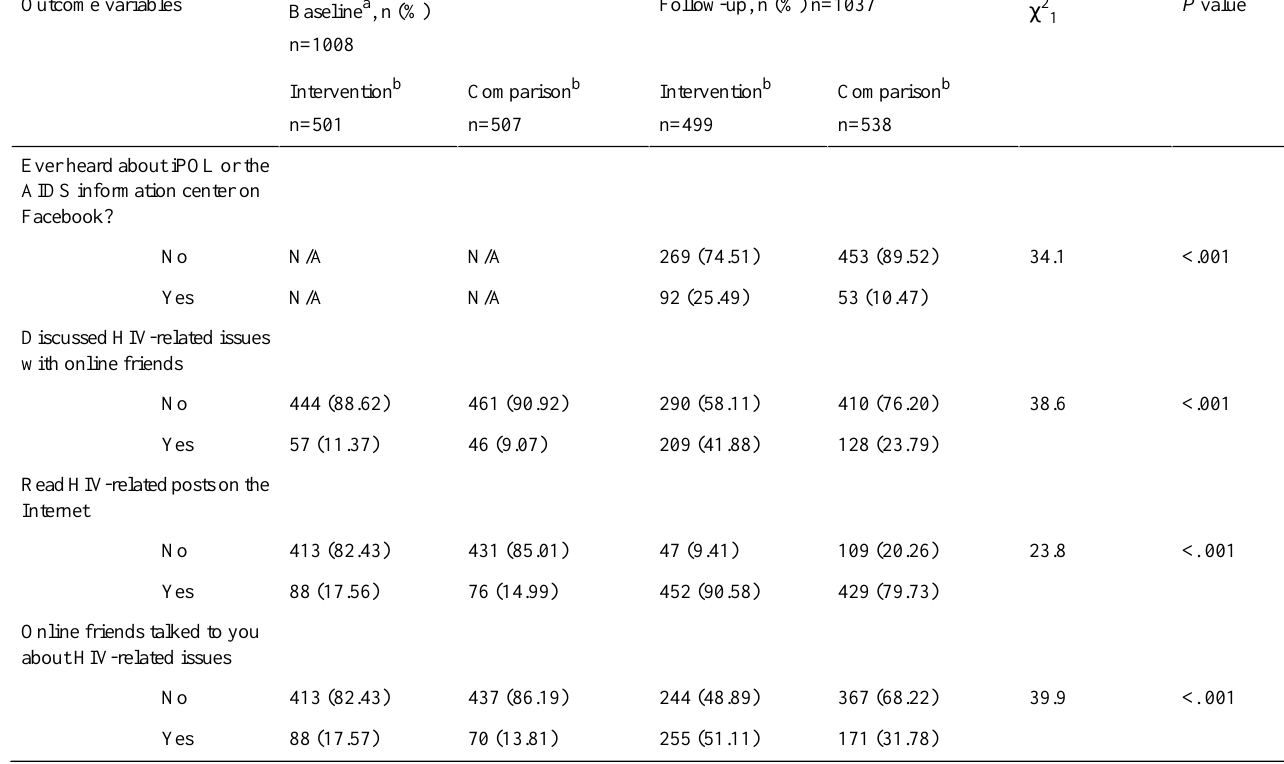
Table 2. Intervention effects on HIV information distribution among Internet-using